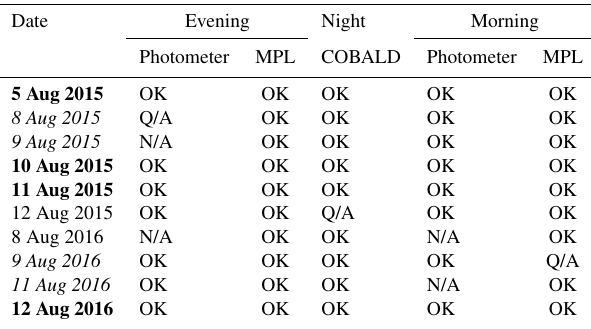
Table 3. The analysis of data availability and quality for different instruments and for different dates of the COBALD flights. OK de- notes data presence, N/A denotes data absence, Q/A indicates ab- sence of quality assured data, bold font indicates presence of full set of data required for the multi-temporal retrieval, and italic indi- cates dates with partial data